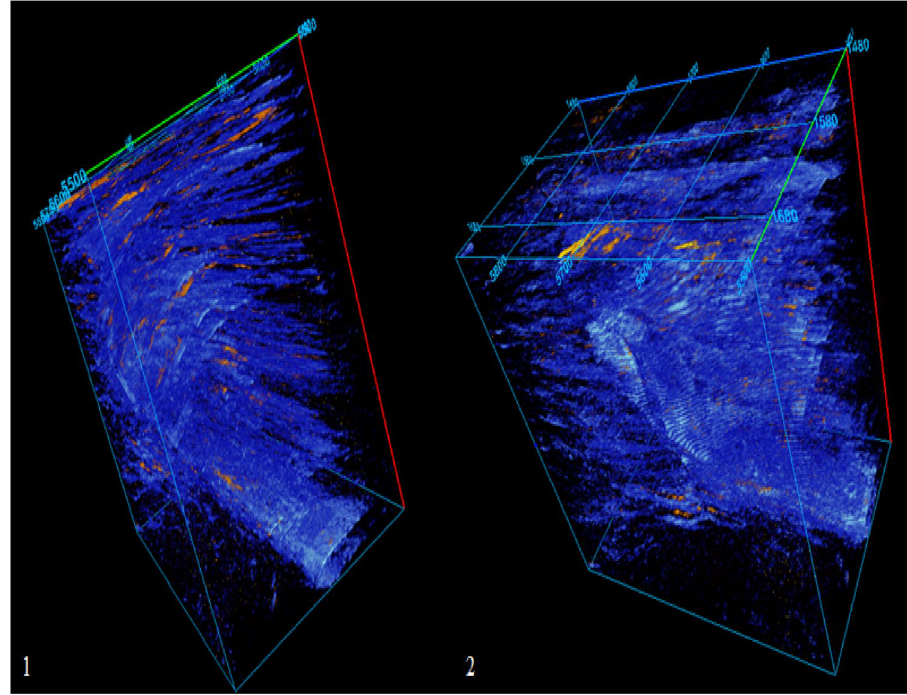
Fig. 3 Seismic cube showing an anticlinal structure (1) and depositional features (2). This figure shows a volume rendered seismic cube that indicates the anticlinal and depositional structures of the study